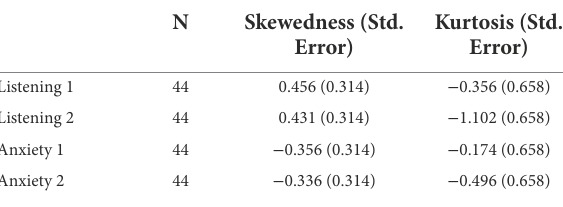
TABLE 1 Test of normality.